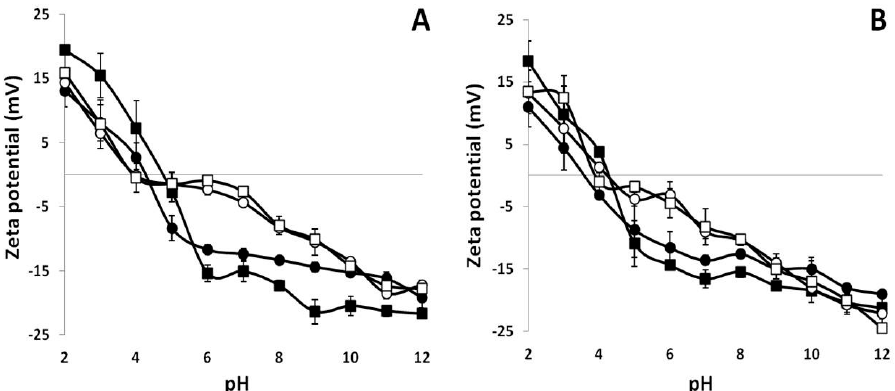
Figure 1. Effect of 5 mM spermidine (SPD) on zeta potential of 25 °C-treated ( A ) and 80 °C-treated ( B ) bitter vetch protein concentrate (BVPC) film forming solutions (FFSs) measured at different pH values in the absence or presence of 42 mM glycerol (GLY). The different FFSs contained only BVPC ( ), BVPC + GLY ( ), BVPC + SPD ( ), BVPC + SPD + GLY ( ). The results are expressed as mean ± standard deviation. Further experimental details are given in the text.